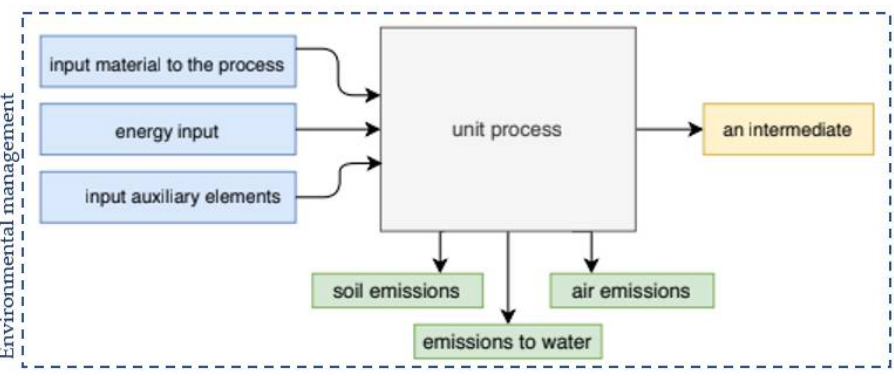
Figure 1. Description of the unit process.